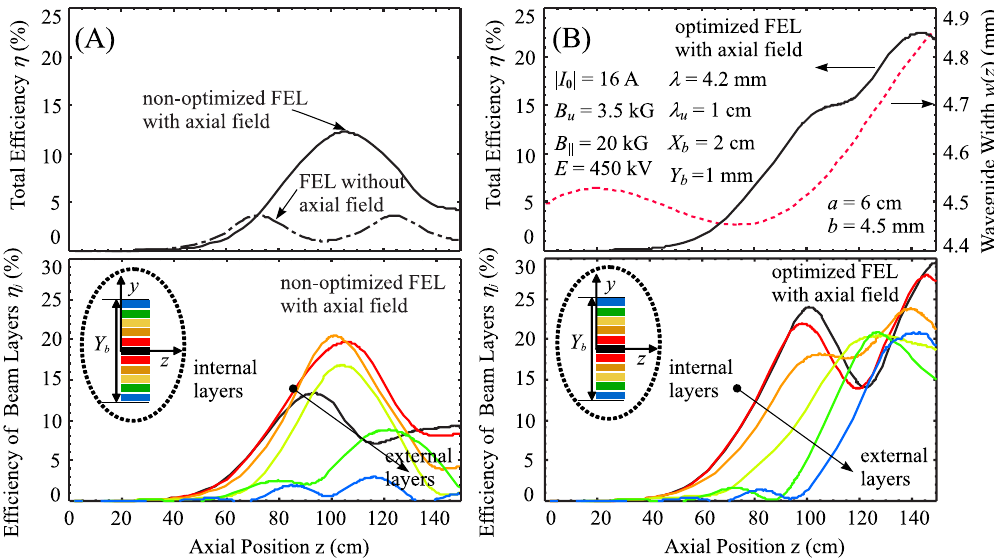
FIG. 9. The total FEL efficiency, the efficiency of electron beam layers, and the waveguide width vs the interaction length. The results of the simulation based on the nonsimplified model given in Sec. II are